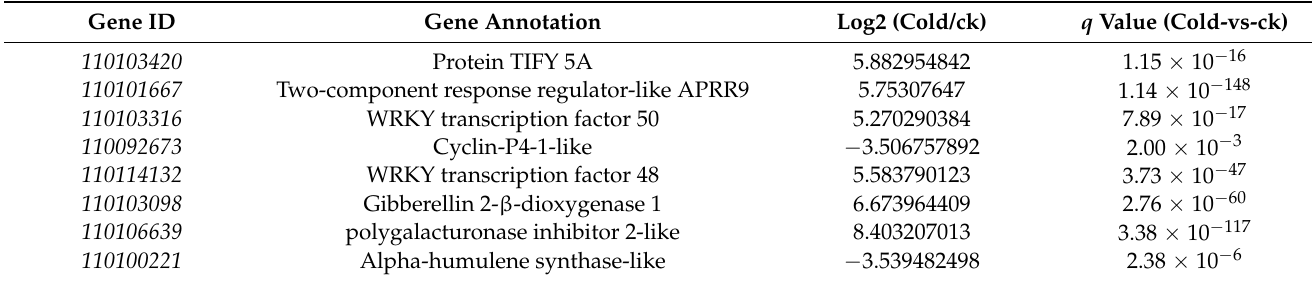
Table 1. Candidate differentially expressed genes in D. catenatum transcriptome.